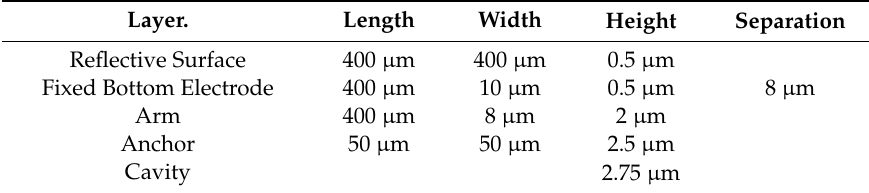
Table 1. Physical properties of the micromirror with the air cavity of 2.75 µm. Layer.